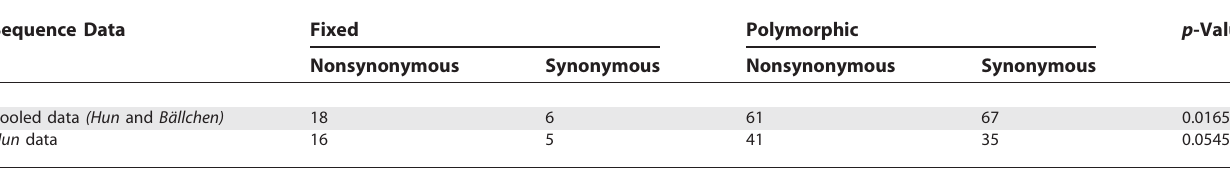
Table 2. McDonald-Kreitman Tests for Pooled and Hun -Only Data Sequence